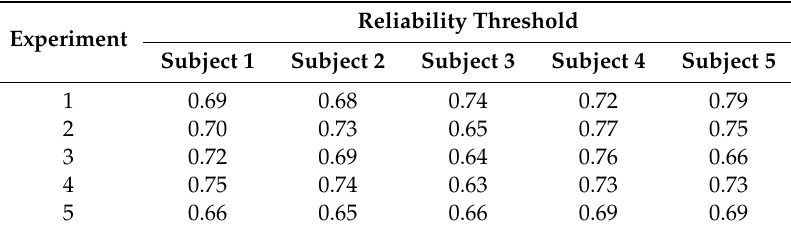
Table 1. Reliability threshold